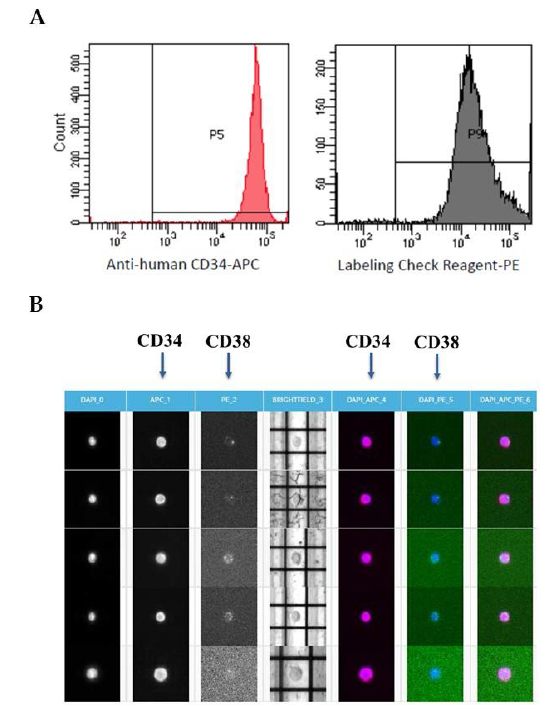
Figure 1. Single-cell sorting using DEPArray. ( A ) Flow cytometry analysis of CD34-positive CD38-negative (CD34 + CD38 + ) cells fixed with 2% PFA overnight. As shown, APC and PE fluorochromes are compatible with PFA. ( B ) Single CD34 +/ CD38- cells sorted by DEPArray, labeled with anti-CD34-APC and anti-beads-PE. The labeling check reagent-PE identifies CD38 expression. All cells have been subjected to DAPI staining in order to assess their viability.